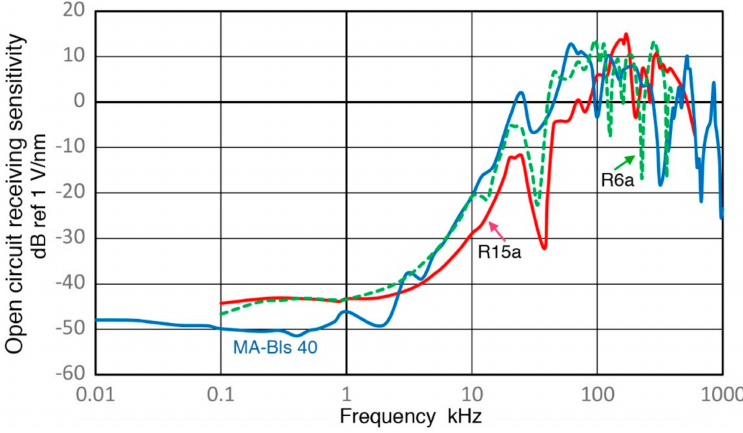
Figure 20. Three open-circuit receiving sensitivity spectra for V189 (0.5: blue), V192 (1.0: red dash) and V103 (1.0: green dash) are compared. Log-frequency scale.